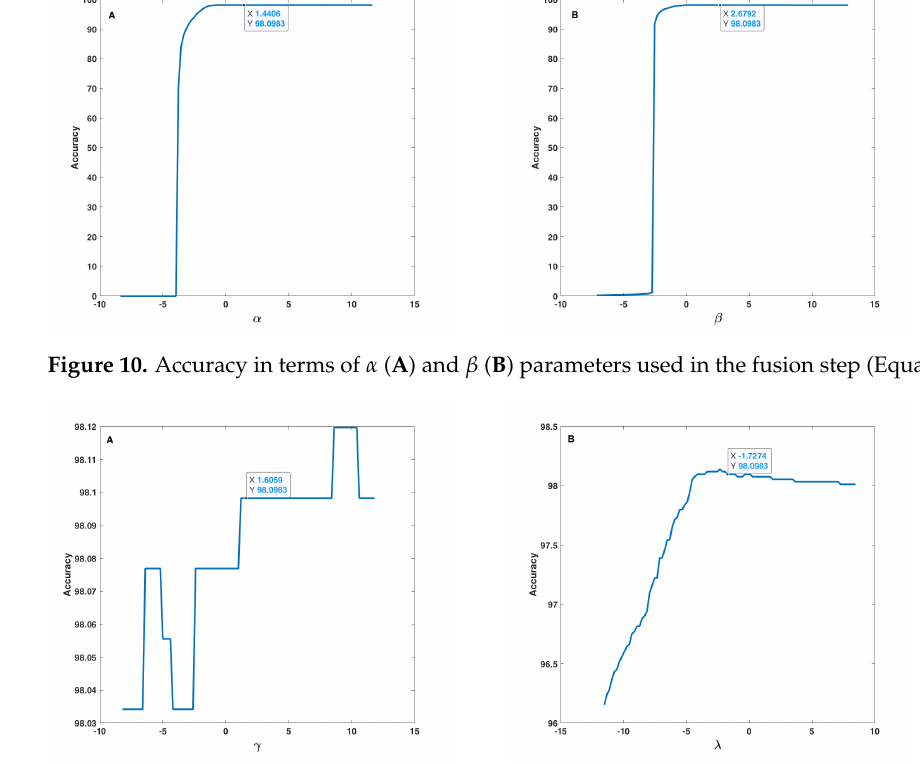
Figure 11. Accuracy in terms of γ ( A ) and λ ( B ) parameters used in the fusion step (Equation